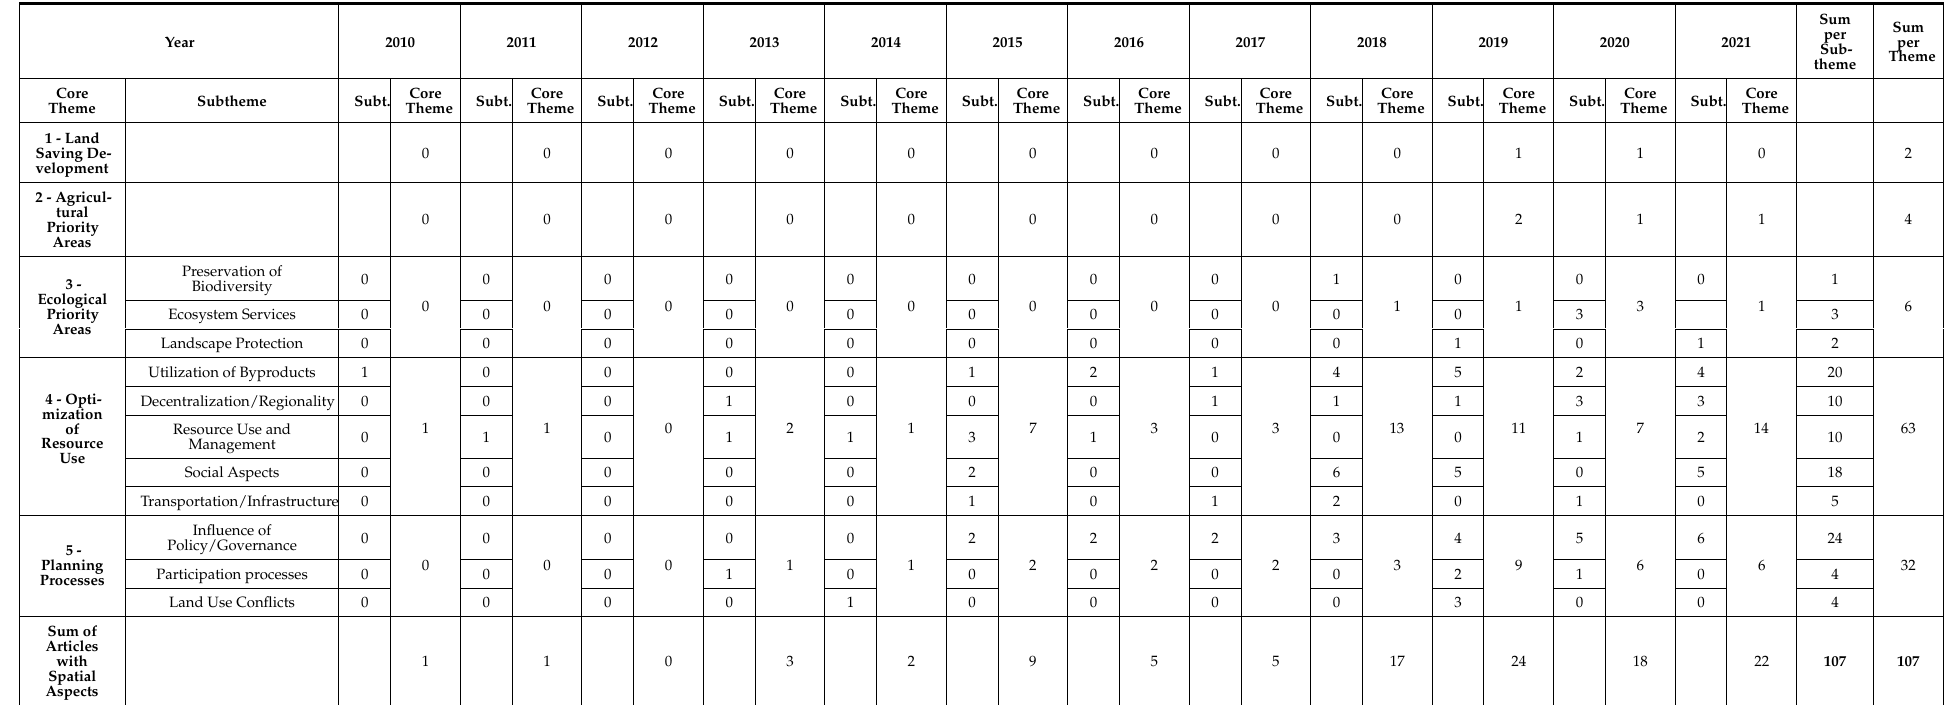
Table A3. Main Table with the results of the selection